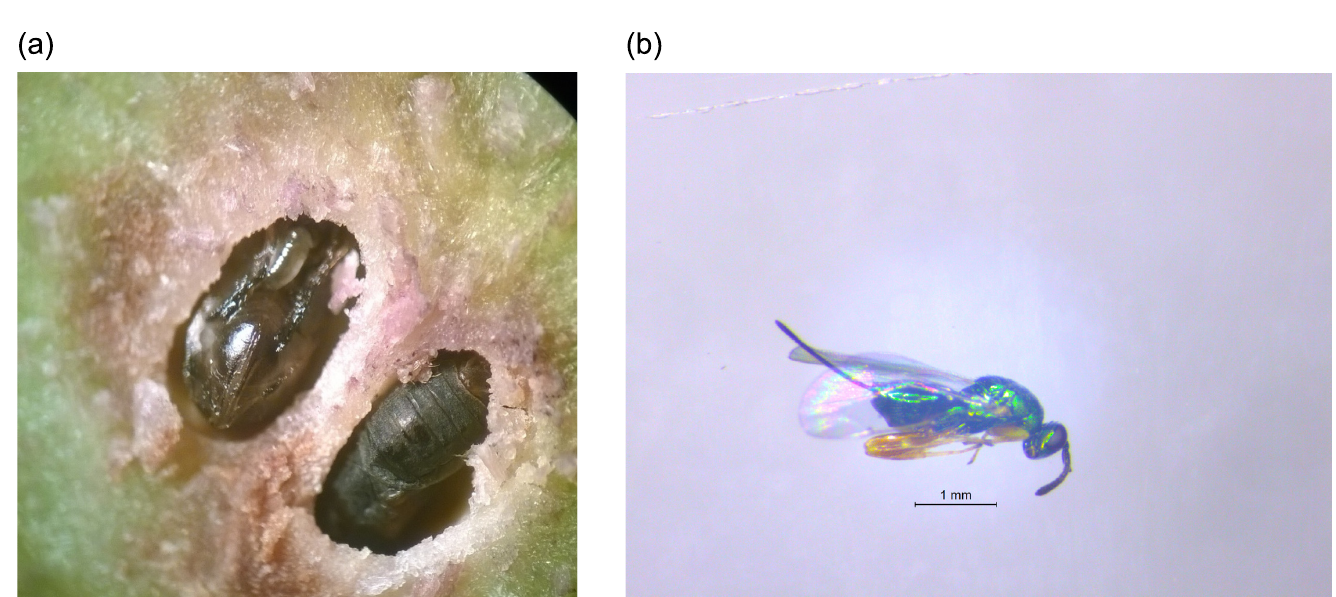
Fig 2. Dryocosmus kuriphilus pupae with parasitoid larvae (a) and adult parasitoid Torymus sinensis (b).